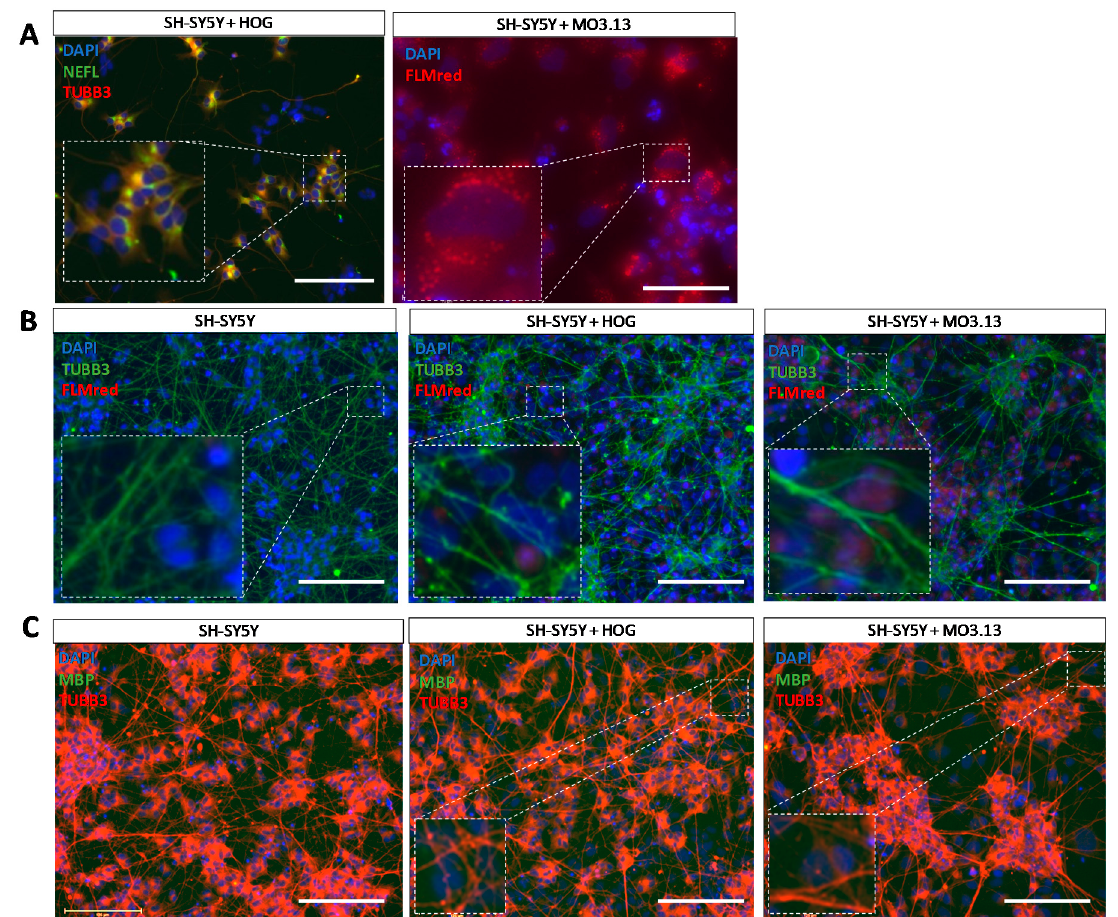
Figure 7. Immunocytochemical analysis of co-cultures of HOG or MO3.13 cells with differentiated neuronal SH-SY5Y cells. ( A ) Representative image of neuronal marker neurofilament light chain (NEFL) and TUBB3 stainings in SH-SY5Y + HOG co-culture and FluoroMyelin Red (FLMred) cytoplasmic lipid droplets in living SH-SY5Y + MO3.13 co-cultures. ( B ) Representative images of TUBB3- and FLMred signals in fixed SH-SY5Y monoculture, and SH-SY5Y + HOG co-culture and SH-SY5Y + MO3.13 co-culture. These images serve as examples for the absence of FLMred overlap with the extensive neurite outgrowth (TUBB3) in our cultures. ( C ) Representative images of the absence of MBP-signals (polyclonal antibody) and the presence of TUBB3-signals in SH-SY5Y monocultures, and SH-SY5Y + HOG and SH-SY5Y + MO3.13 co-cultures. Scale bar = 50 μ m.